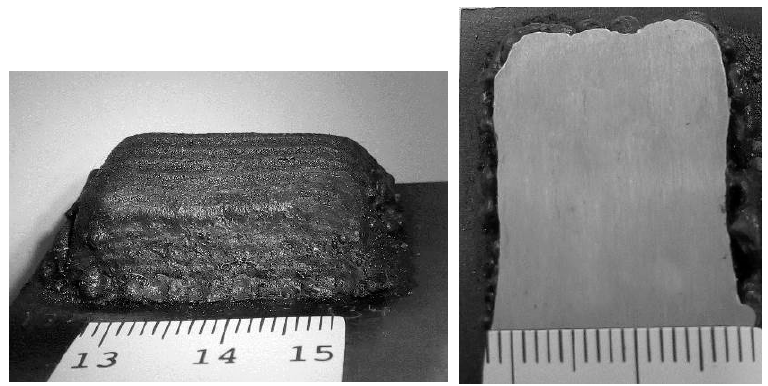
Figure 10. Pictures of general views of a solid piece and its machined surface.